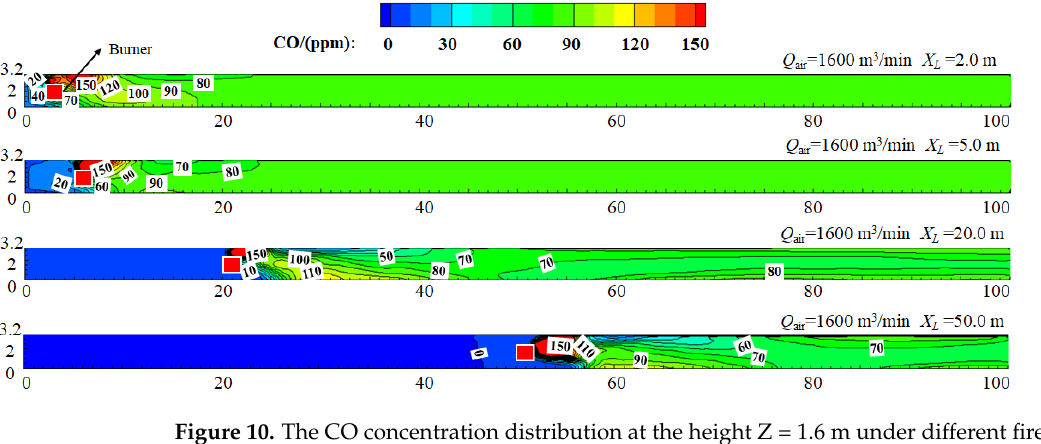
Figure 10. The CO concentration distribution at the height Z = 1.6 m under different fire locations.